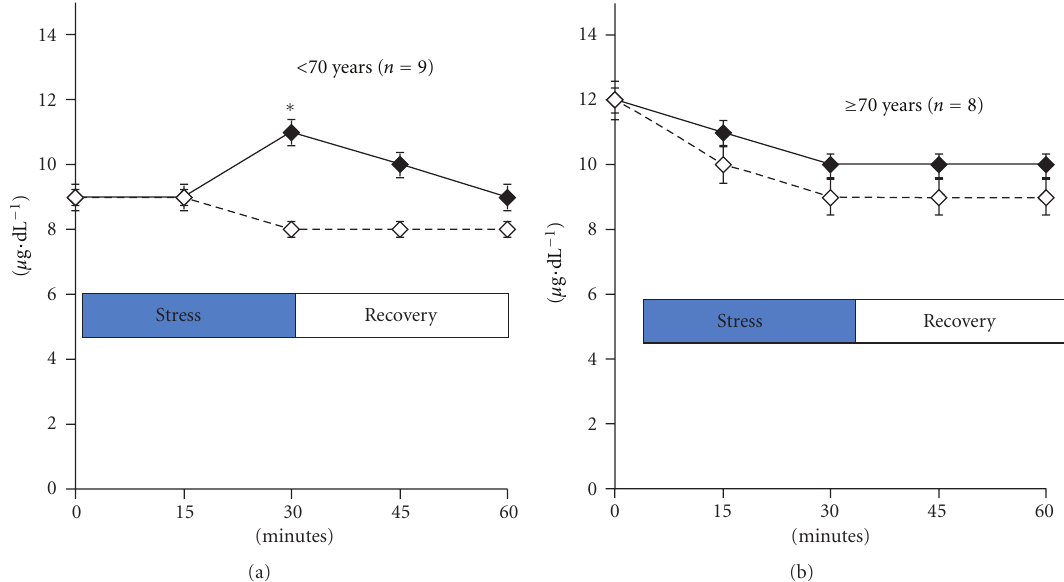
Figure 2: Cortisol responses between the stress condition (solid line) and the control (broken line) condition by age group. Age groups are based on the median cut point of the distribution. Data are mean ± se; N = 17; ∗ P < 0 . 05.